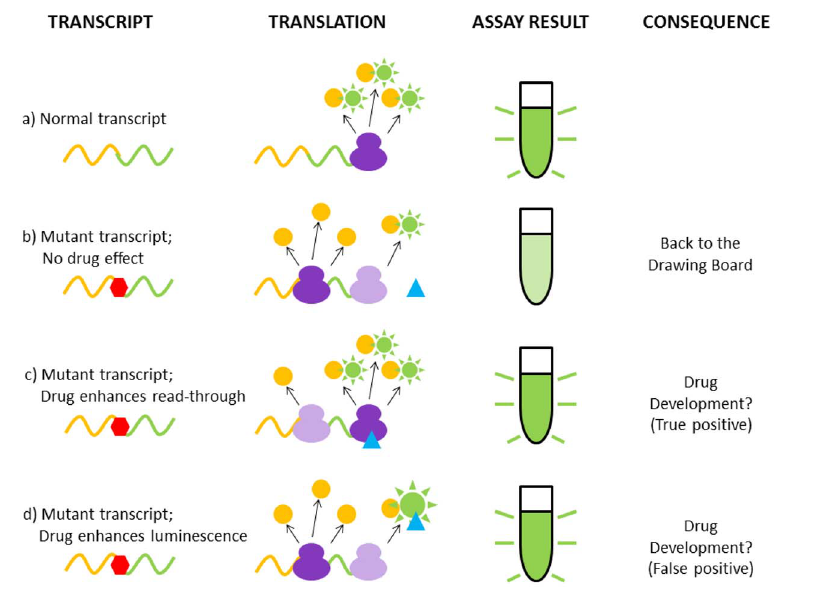
Figure 1. When good assays turn bad. a) A ribosome (dark purple) runs along a normal transcript (wiggly orange/green line), translating it into protein (orange circle – upstream region; green sun – luciferase), which then emits light in the assay. b) A nonsense mutation (red hexagon) stops most of the ribosomes in the middle of the transcript, producing a truncated,